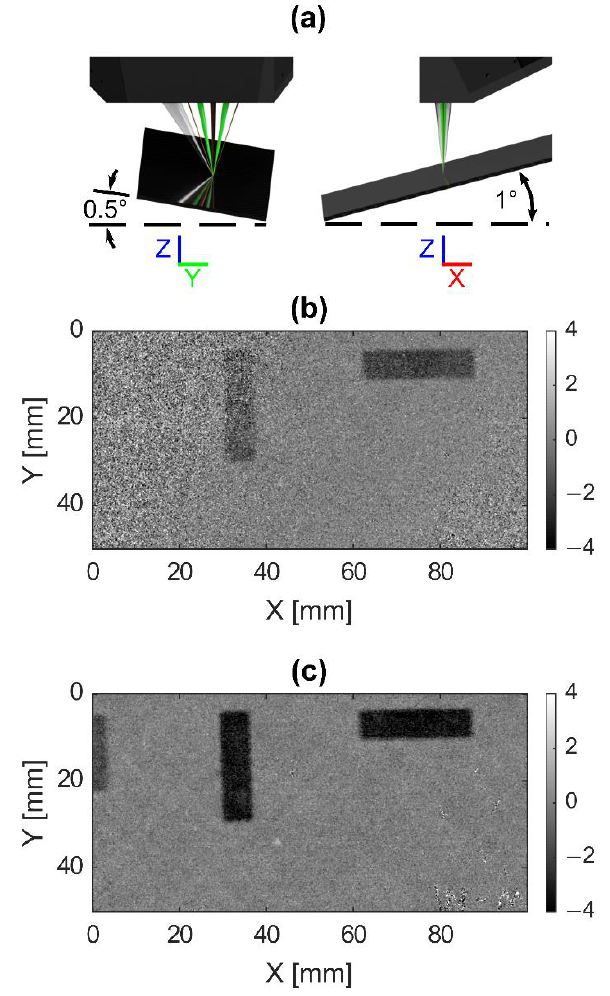
Figure 8. ( a ) Diagram of sample tilt 1° about the Y -axis, and 0.5° about the X axis for two-dimensional laser-ultrasound (LU) scanning. C-scans at a 1.5 mm sample depth for DACs regulation OFF ( b )